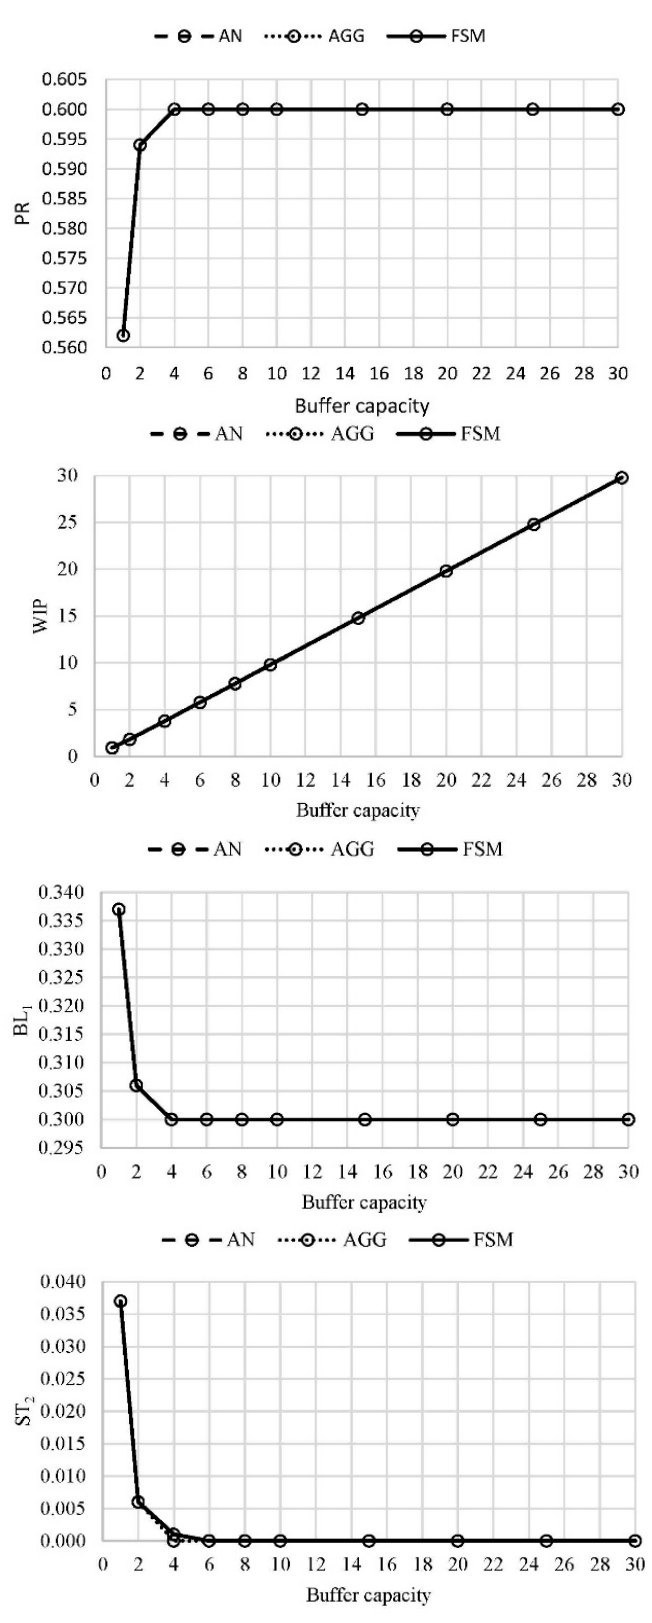
Figure 4. PR , WIP , BL 1 , and ST 2 in case of the line L 1 (authors’ work).